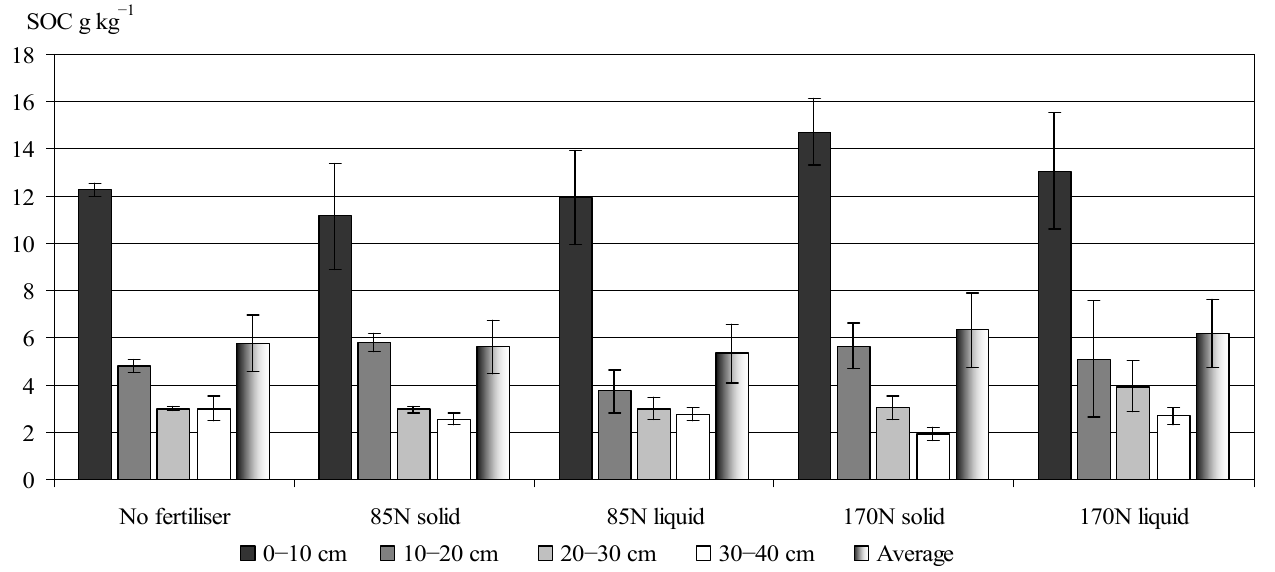
Figure 7. SOC content in grassland in Retisol, 2020 .